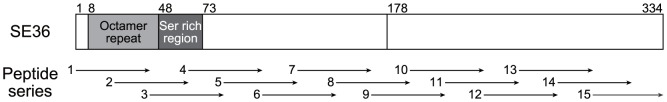
Schematic representation of synthetic peptide series I covering the whole sequence of SE36 protein.The number 178 denotes the position of polyserine sequence present in PfSERA5 but deleted in SE36 [5].